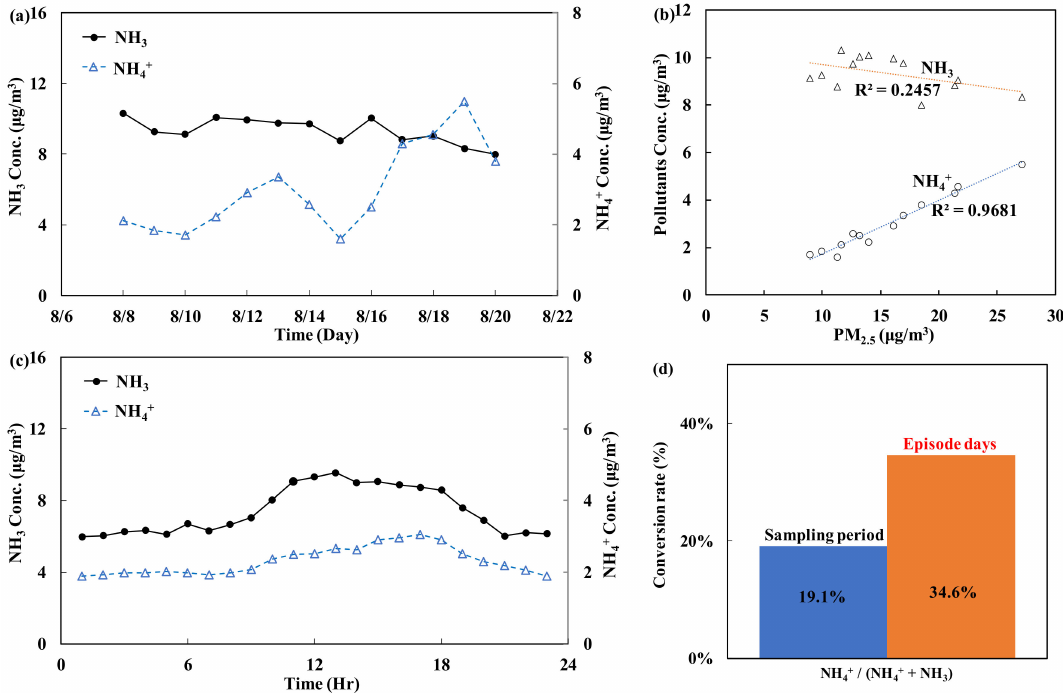
Figure 6. Trends in the daily and hourly average concentrations and conversion analysis of NH 3 /NH 4+ : ( a ) daily average trend; ( b ) correlation with PM 2.5 ; ( c ) hourly average trend; and ( d ) conversion